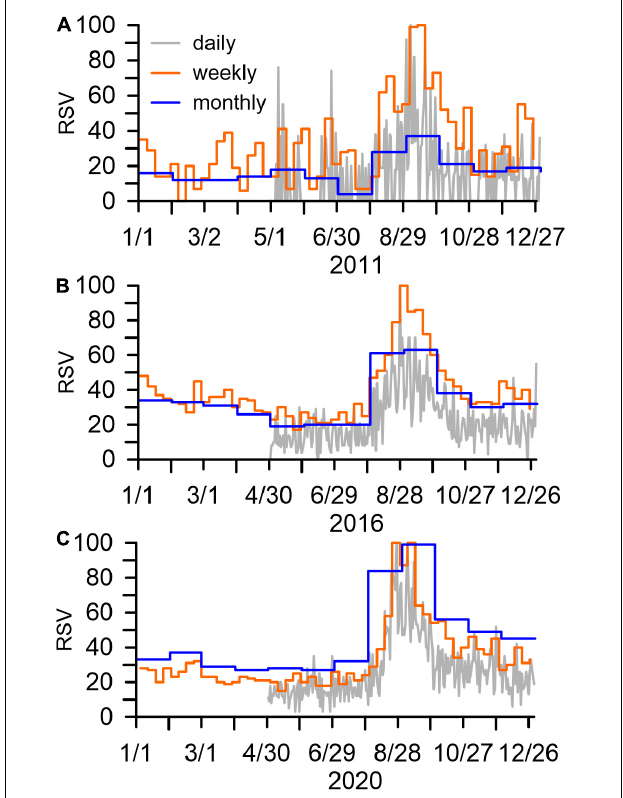
FIGURE 2 | Relative search volume (RSV) calculated in daily, weekly, and monthly time steps for lingonberry across Russia in (A) 2011, (B) 2016, and (C)